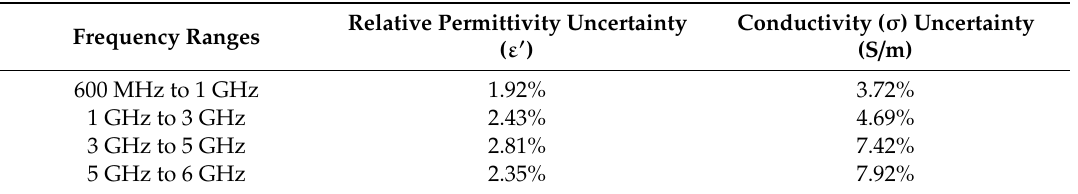
Table 1. Evaluations of the Type A uncertainty associated with dielectric measurements on the broadband phantom liquid made by using the Agilent 85070E 3.5 mm coaxial probe, presented at coverage factor k = 2 (equivalent to 95% confidence level).